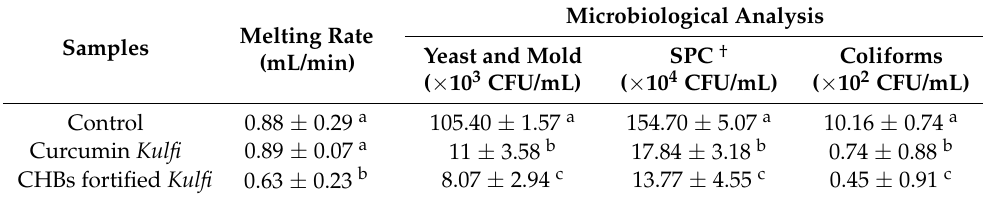
Table 3. Melting rate and microbiological analysis of Kulfi fortified with CHBs 1